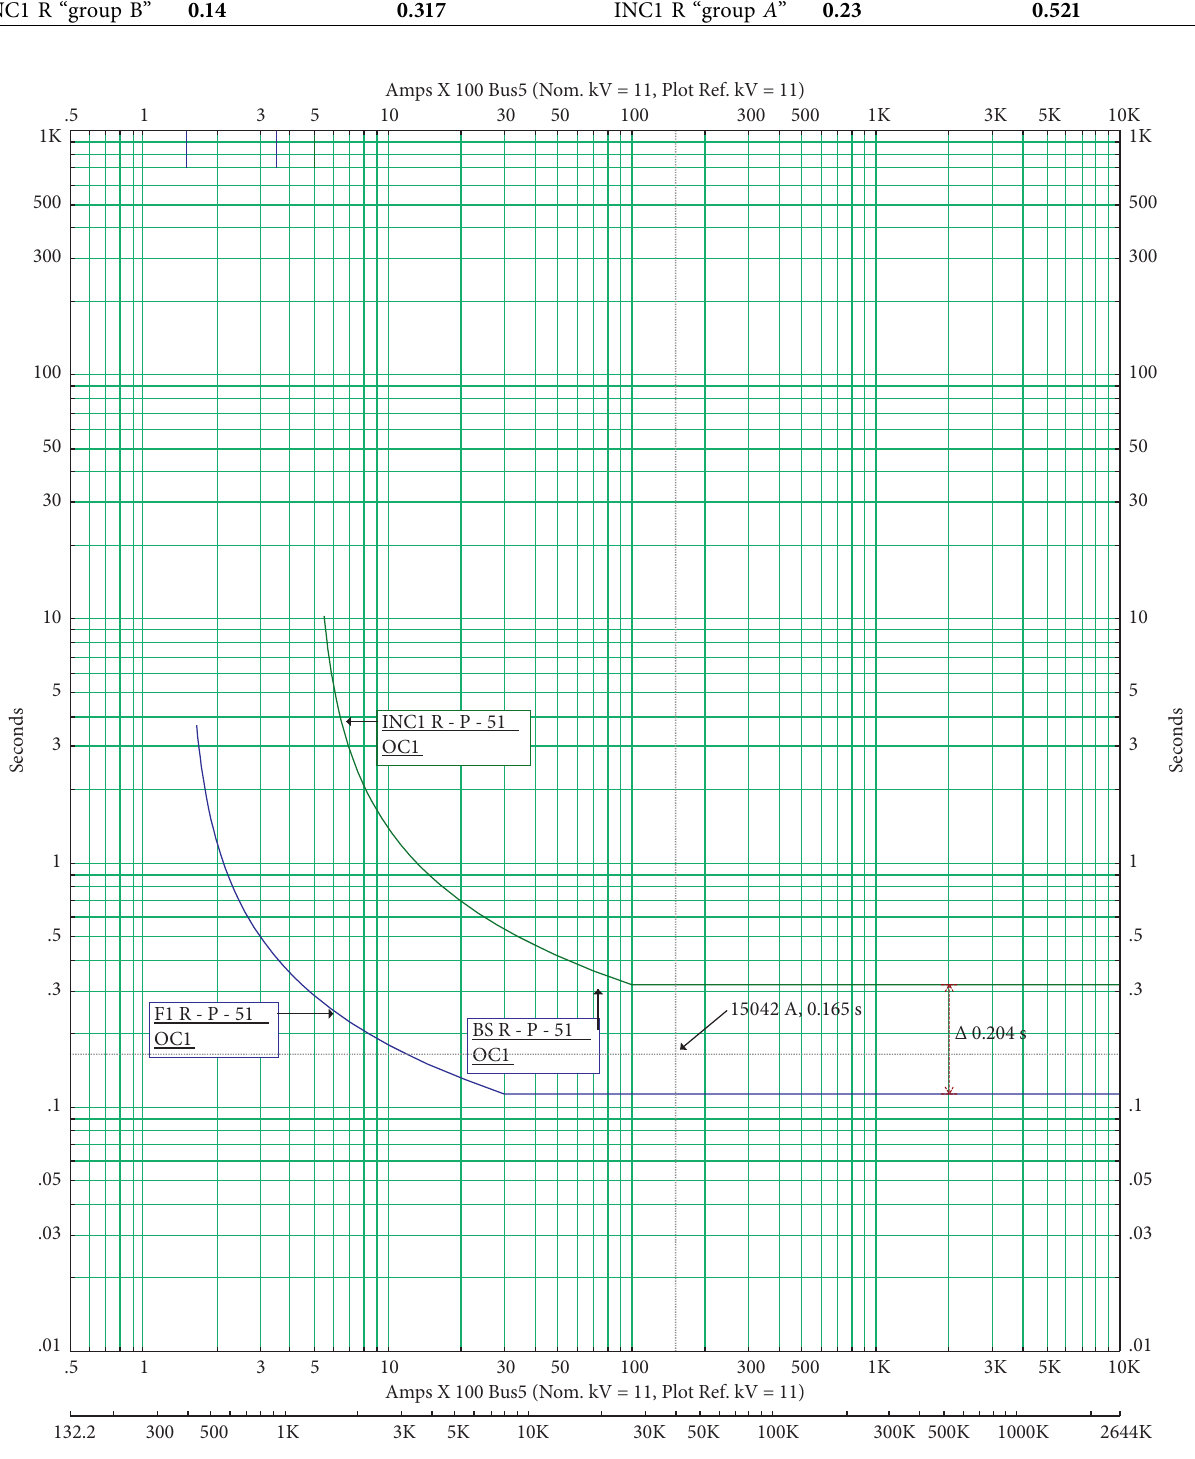
Figure 13: Relays (F1, BS, INC1) coordination with the proposed method, INC1 R group “ B